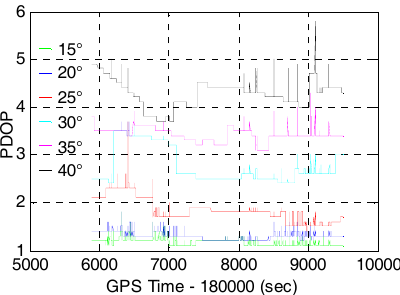
Figure 7. PDOP of GPS/BDS/GLONASS (G+C+R) with cut-off elevation angle ranging between 15 ◦ and 40 ◦ .